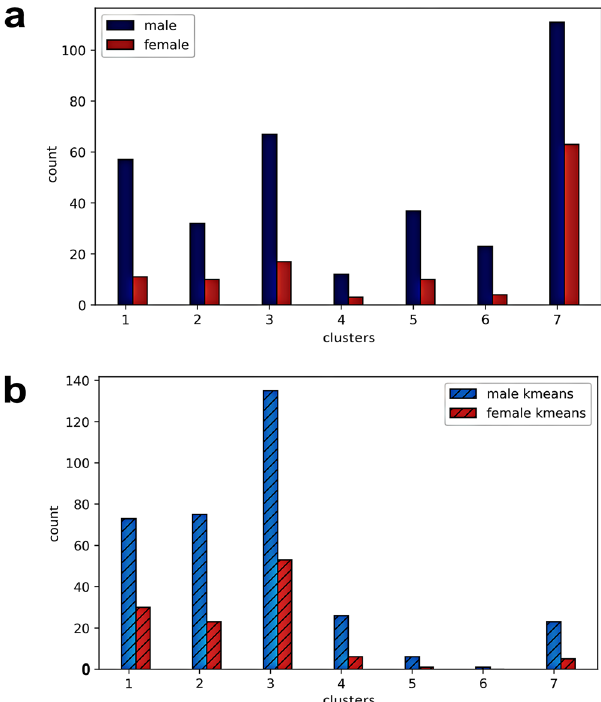
Fig. 10 Results of clustering. a Hierarchical clustering, b Clustering with k -